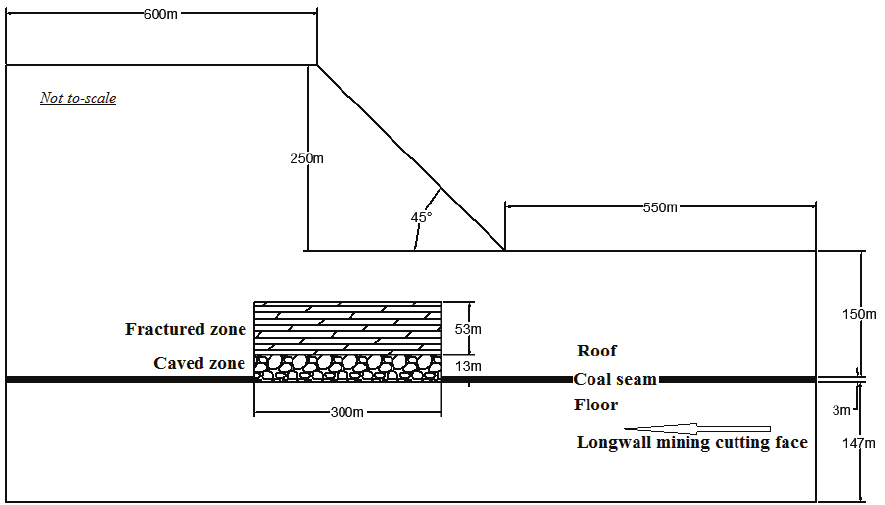
Fig. 10. Two-dimensional numerical model dal case study III.